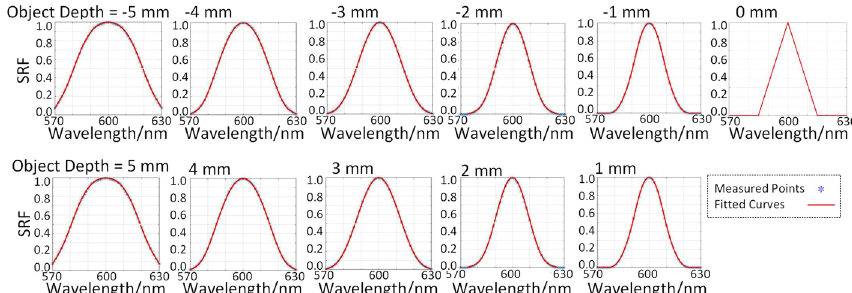
Fig. 12 The SRFs of refocused images with different object depths at center wavelength 600 nm. The object depth of each figure is noted on the top. The object depth of the figures in first line are 5 mm, 4 mm, 3 mm, 2 mm, 1 mm and 0 mm, respectively. The object depth of the figures in − − − − − second line are 5 mm, 4 mm, 3 mm, 2 mm and 1 mm,